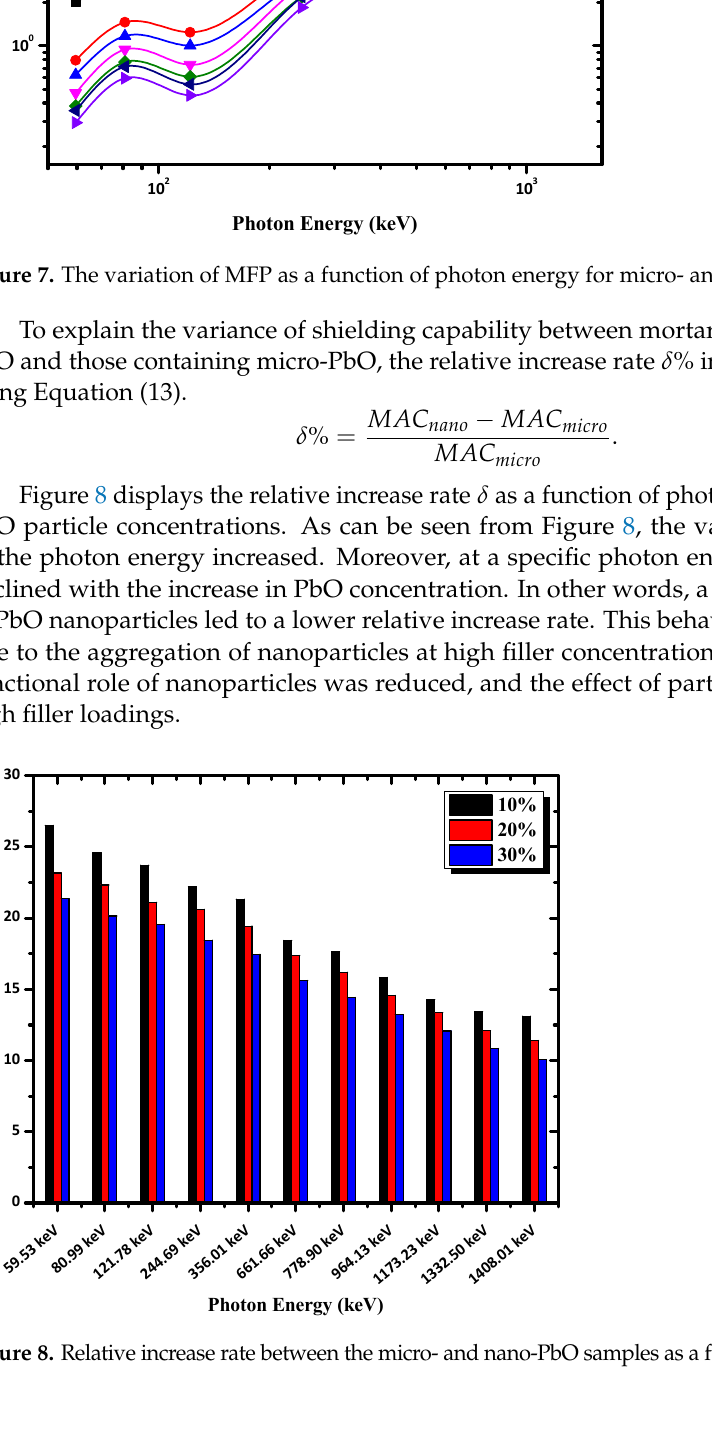
Figure 8. Relative increase rate between the micro- and nano-PbO samples as a function of photon energy. The variations of the effective atomic number (Z eff ) and effective electron density (N eff ) for total photon interactions of micro-PbO/gypsum mortars are shown in Figure 9 and Figure 10, respectively. Z eff and N eff for the selected mortars are plotted in the energy range 0.015–15 MeV. It can be observed that the Z eff values depended on the incident pho- ton energy and increased with increasing PbO concentration. Thus, values of Z eff for GLM- mPbO30% samples were higher than those of the other samples in the low-energy range (0.015 MeV–0.2 MeV) due to the dominance of photoelectric absorption in this region. Therefore, GLM-mPbO30% samples could be considered better at shielding low-energy gamma-rays due to the high concentration of PbO, which could absorb the incident pho- tons via the photoelectric mechanism. The highest Z eff values found for mortars GLM- mPbO30%, GLM-mPbO20%, and GLM-mPbO10% were at E = 0.1 MeV due to the K ab- sorption edge of Pb at 88 keV. However, at medium and high energy, Z eff values rapidly decreased with increasing energy, where Compton scattering and pair production mech- anisms became predominant. The dependence of N eff on the incident photon energy is similar to that described for Z eff .